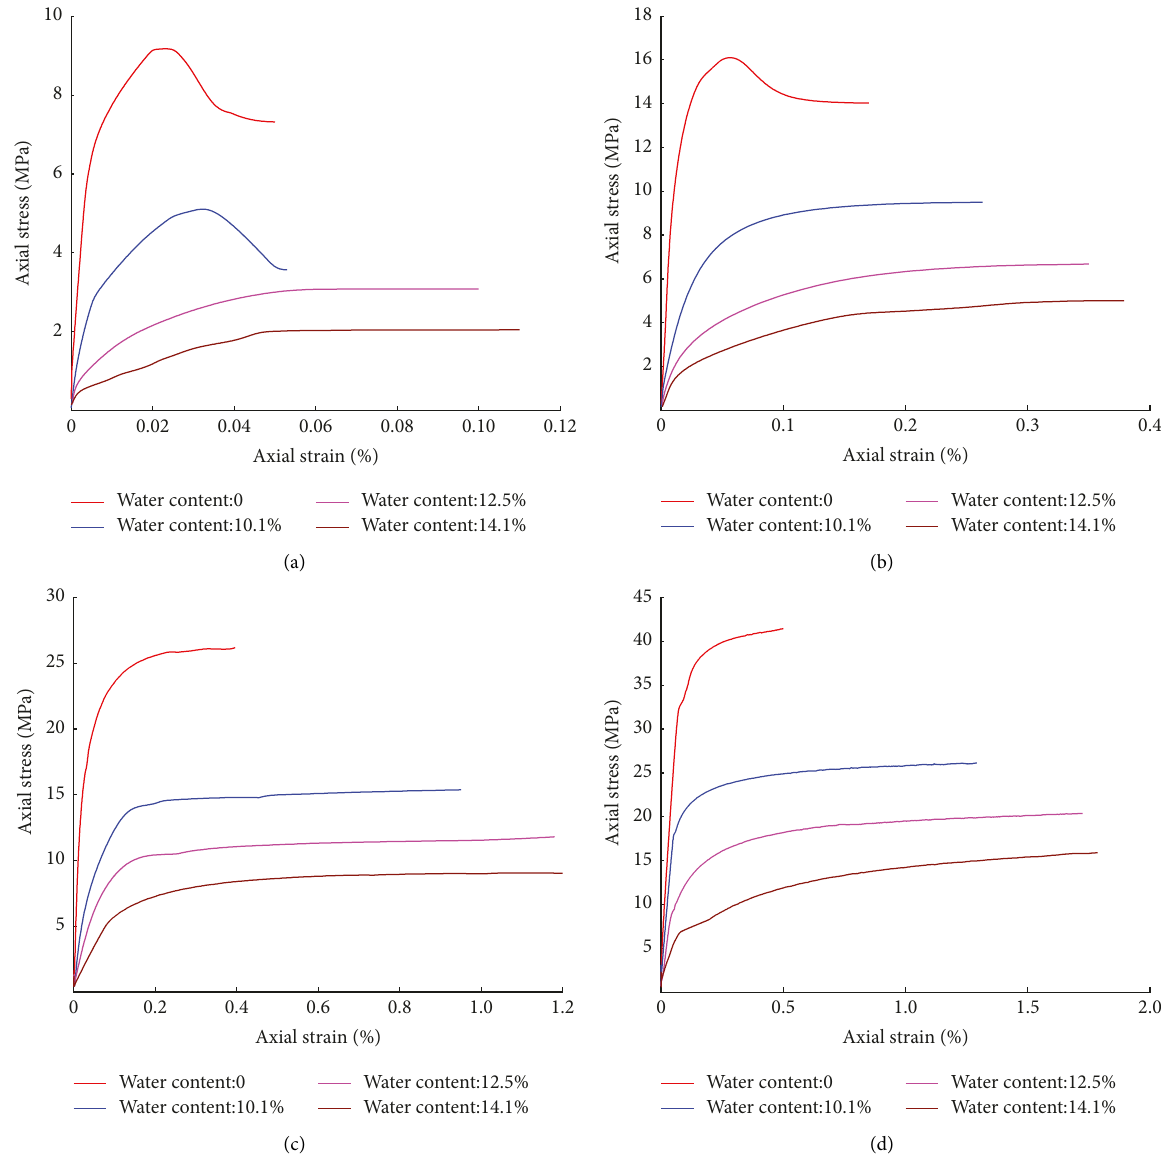
Figure 7: Stress-strain curves of mudstone under four water content under different confining pressures. (a) Confining pressure: 0MPa. (b) Confining pressure: 2MPa. (c) Confining pressure: 5MPa. (d) Confining pressure: 10